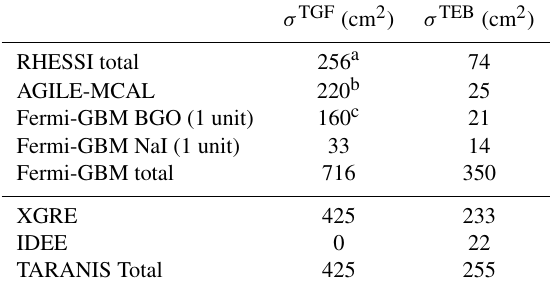
Table 1. Summary of the TGF-spectrum averaged ( σ TGF ) and TEB- spectrum averaged ( σ TEB ) effective areas of RHESSI, AGILE, Fermi and